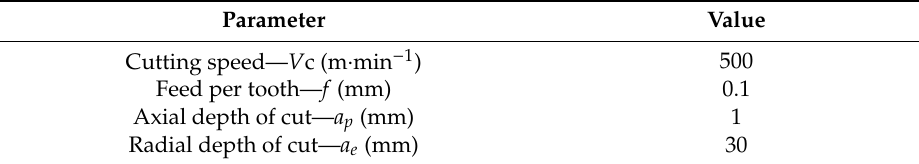
Table 2. Cutting conditions employed during the experimental test.